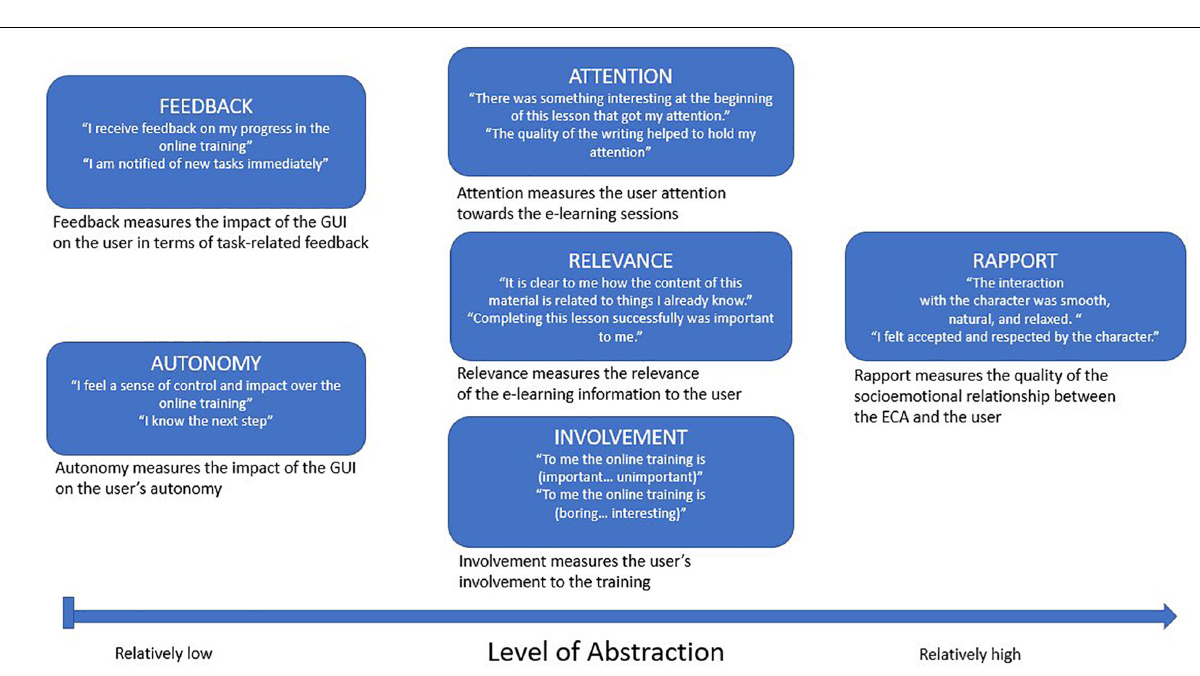
FIGURE 5 | Sequence order of the outcome variables in terms of level of